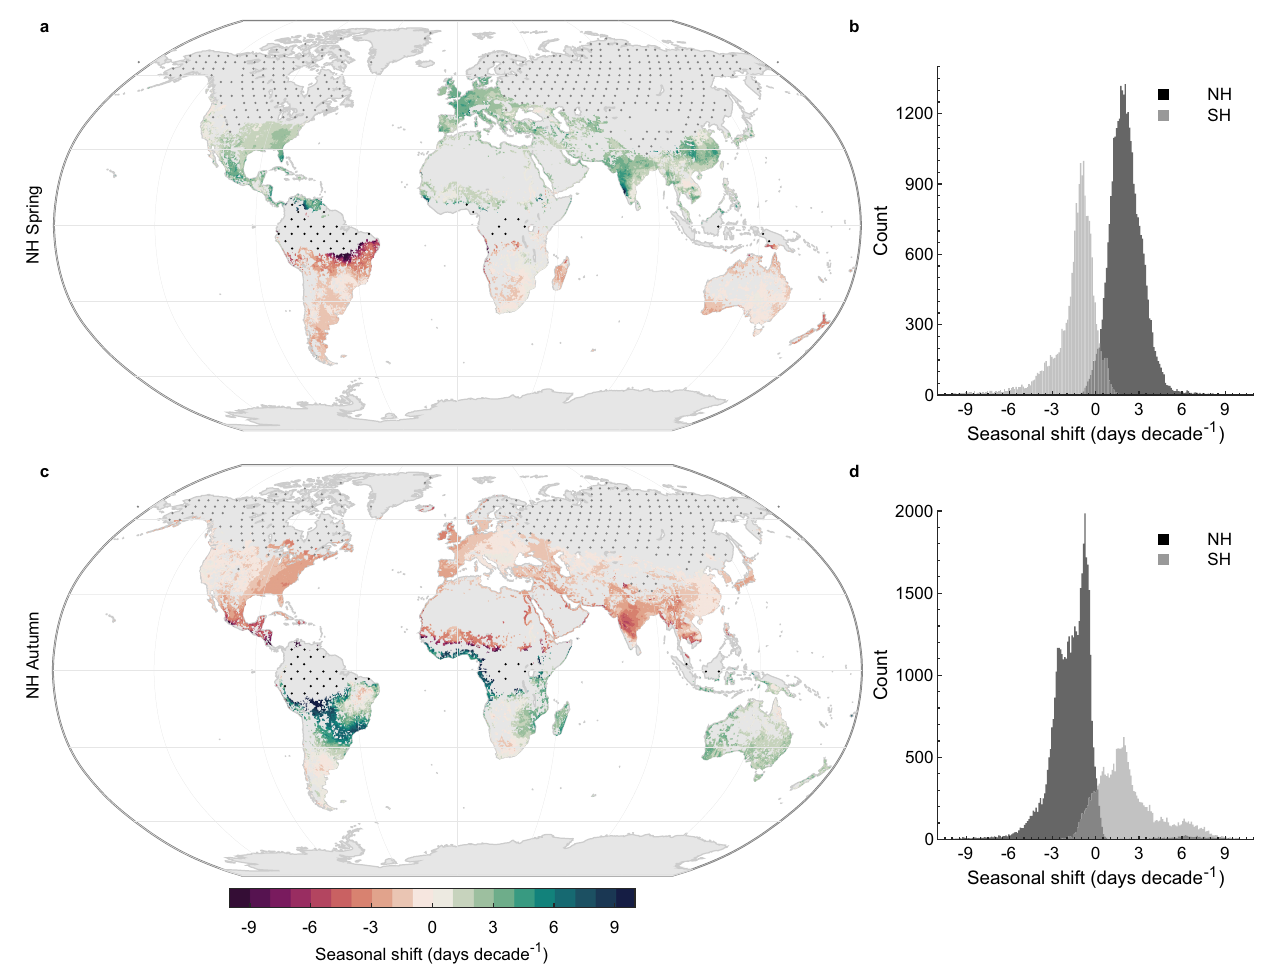
Fig.1|Seasonalshiftsinthetimingofspringandautumninlakes. Shownarethe seasonal shifts (days decade − 1 ) in the timing of spring (March – May in Northern Hemisphere [NH] and September-November in the Southern Hemisphere [SH]), and autumn (September – November in the Northern Hemisphere and March – May in Southern Hemisphere) temperatures in lakes worldwide during the historic to contemporary period (1980 – 2021). Panels ( a ) and ( b ) show the seasonal shifts in NH spring and SH autumn, and panels ( c ) and ( d ) show the seasonal shifts in NH